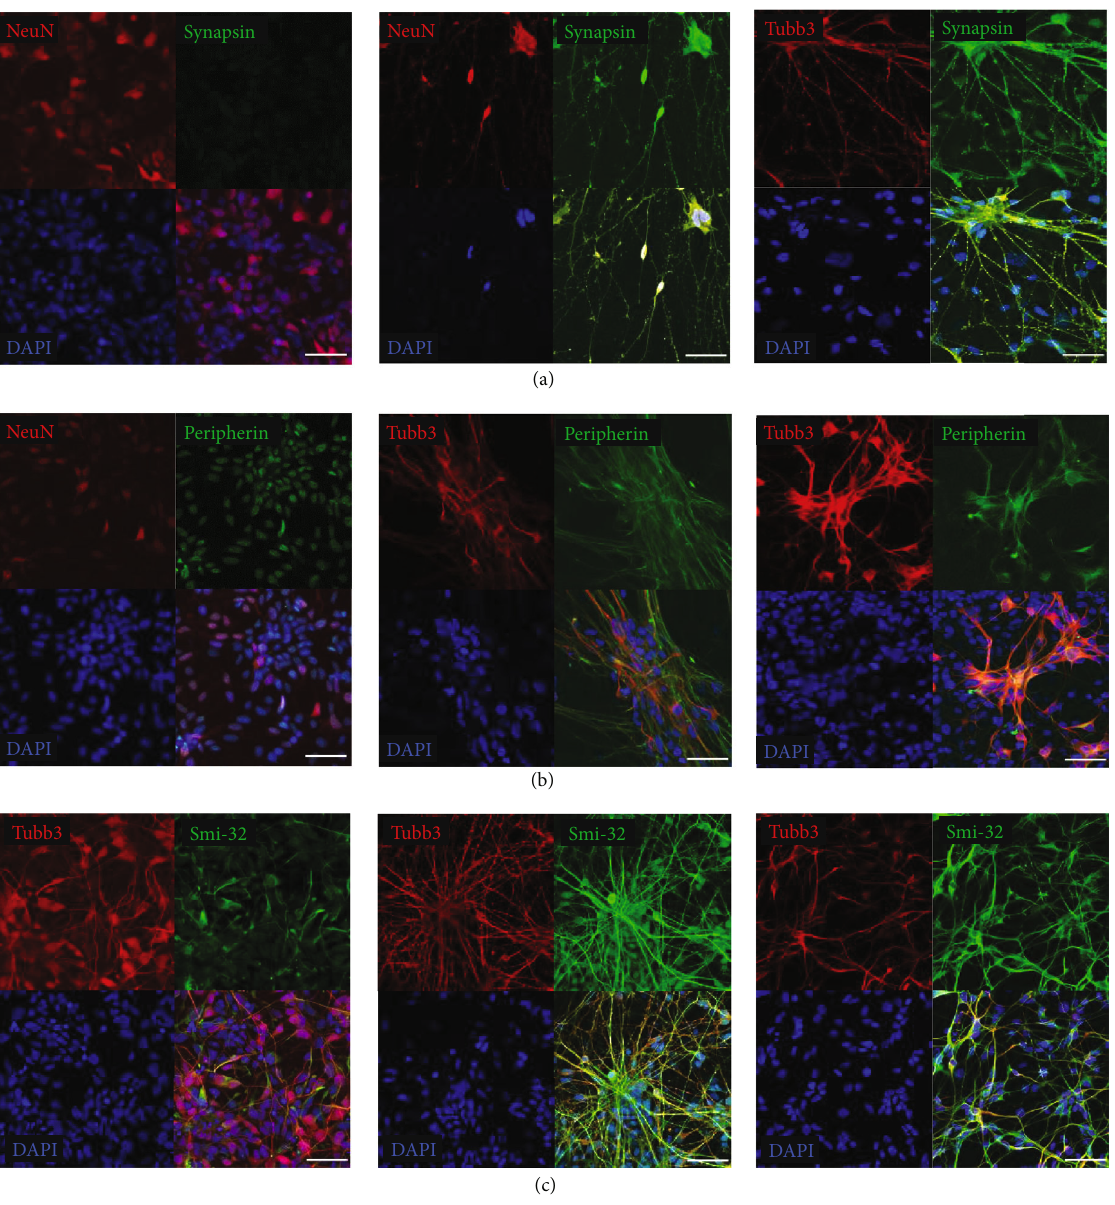
Figure 7: Expression of Synapsin-1, Peripherin, and Smi-32 indicate neuronal functionality. (a) Representative immuno fl uorescent images show Synapsin-1 positive synaptic vesicles stained in green puncta as well as (b) Peripherin- and (c) Smi-32-positive neuronal fi laments (green) in neurons of approach A and B, which were not detected in NPC. Cell nuclei were counterstained with DAPI (blue) ( n = three independent experiments). All scale bars, 50 μ